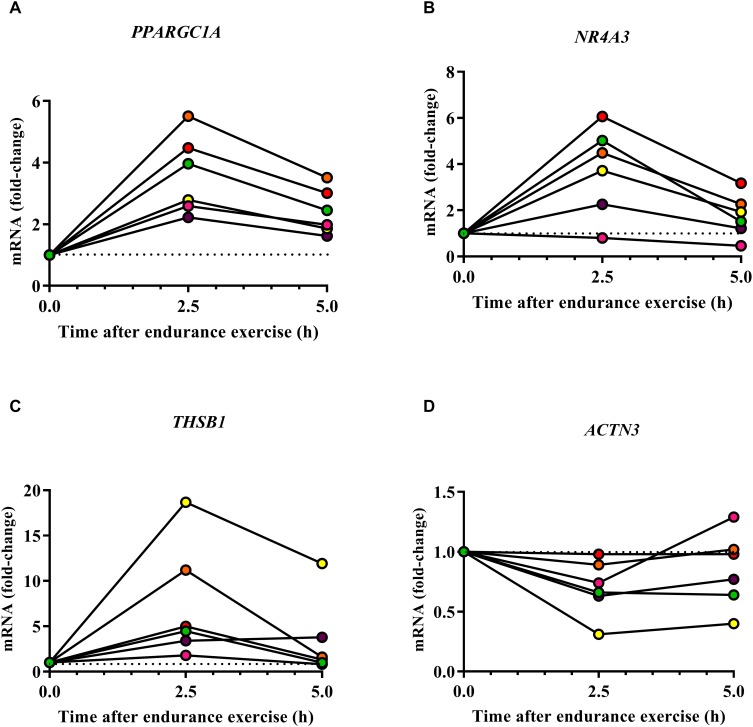
Effect of human endurance exercise on the expression of PPARGC1A
(A), NR4A3
(B), THSB1
(C), and ACTN3
(D) in the vastus lateralis 2.5 and 5 h after exercise (Vissing and Schjerling, 2014).